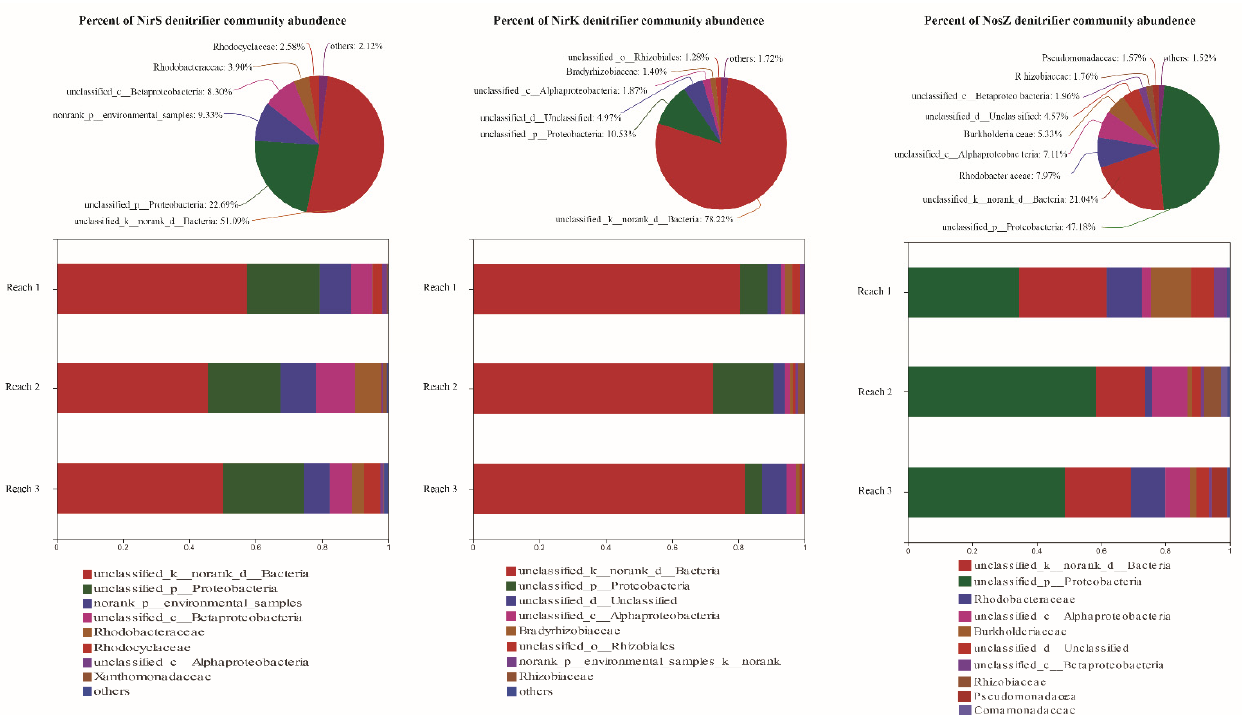
Figure 3. nirS, nirK, and nosZ denitrifier communities (on family level against the FunGene database) in permeable sandy sediments from three different reaches.